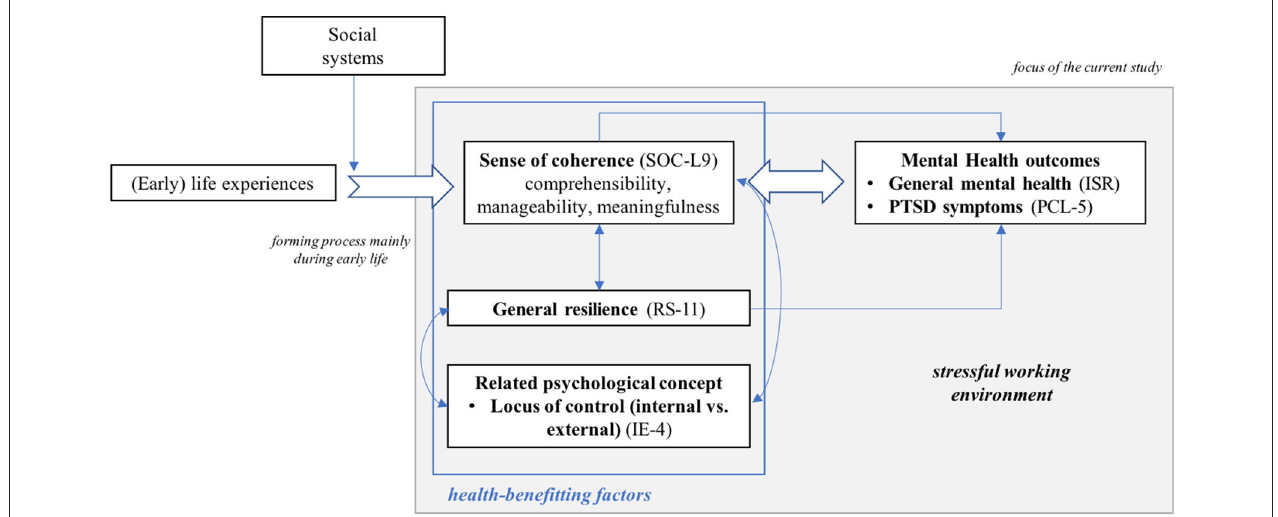
FIGURE 1 | Schematic illustration of the theoretical